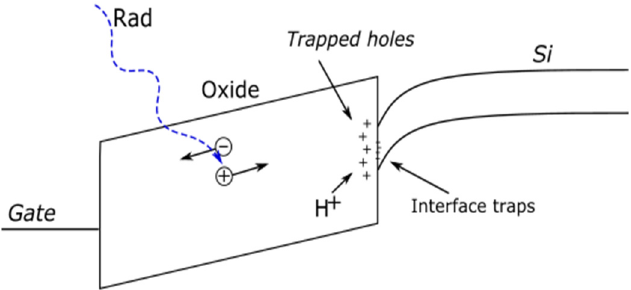
Figure 2. N-MOSFET energy bands diagram with gate-substrate biased to positive voltage.